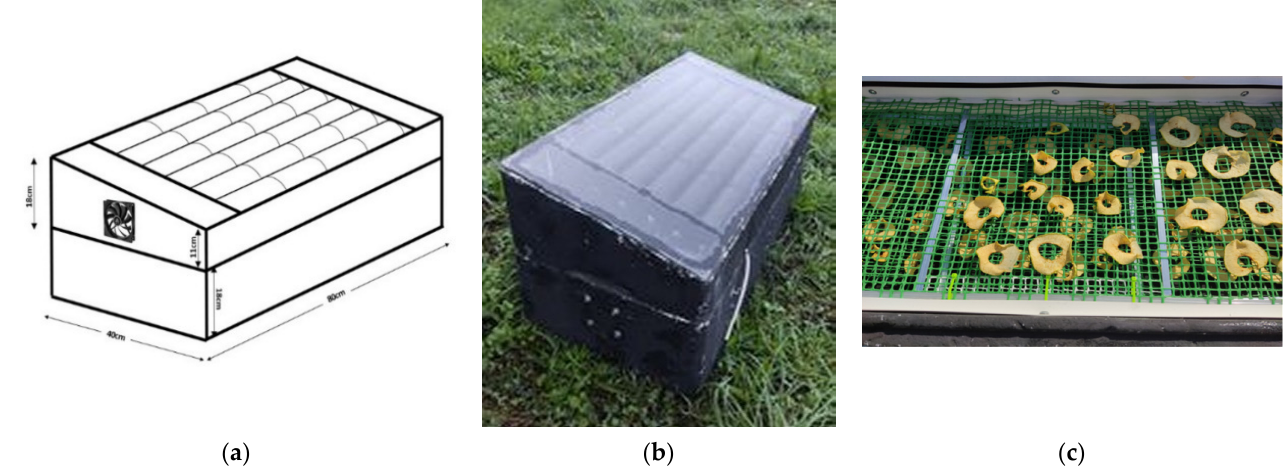
Figure 2. ( a ) Scheme of Prototype 2; ( b ) Solar panel and drying chamber made of styrofoam and aluminum cans; ( c ) drying chamber tray with sliced apples.